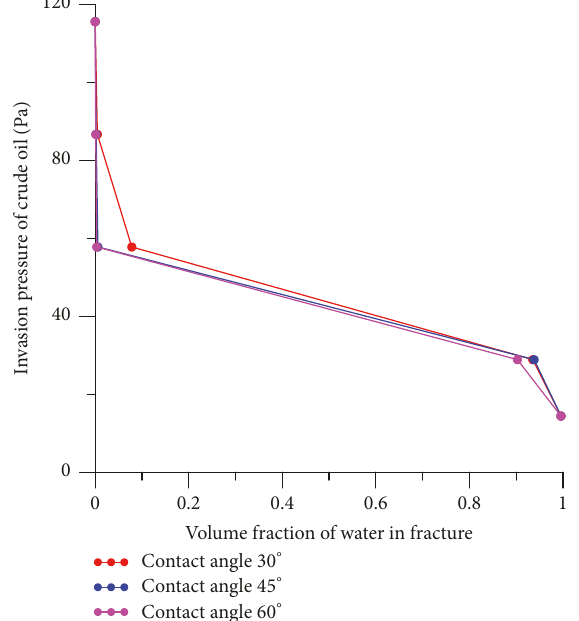
Figure 14: Relationship between the invasion pressure of crude oil and the volume fraction of water in the fracture for different contact angles at time 15s (FD =